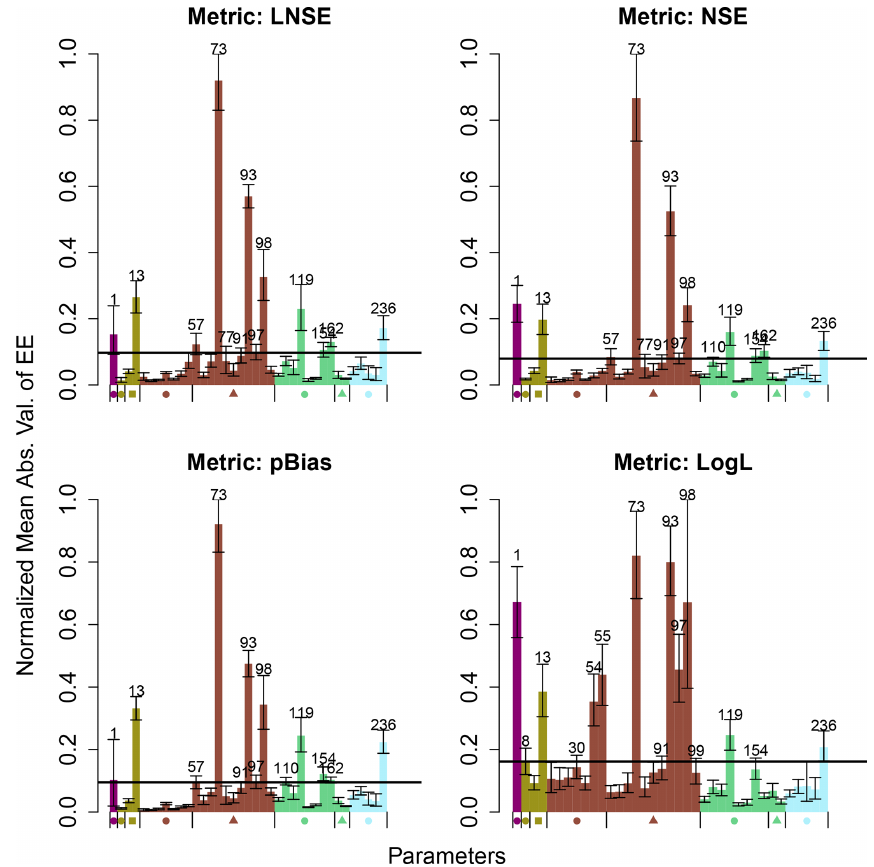
Figure 6. Mean absolute value of elementary effects for RHESSys model parameters evaluated for the four calibration-relevant sensitivity metrics at the basin outlet. The style matches Fig.